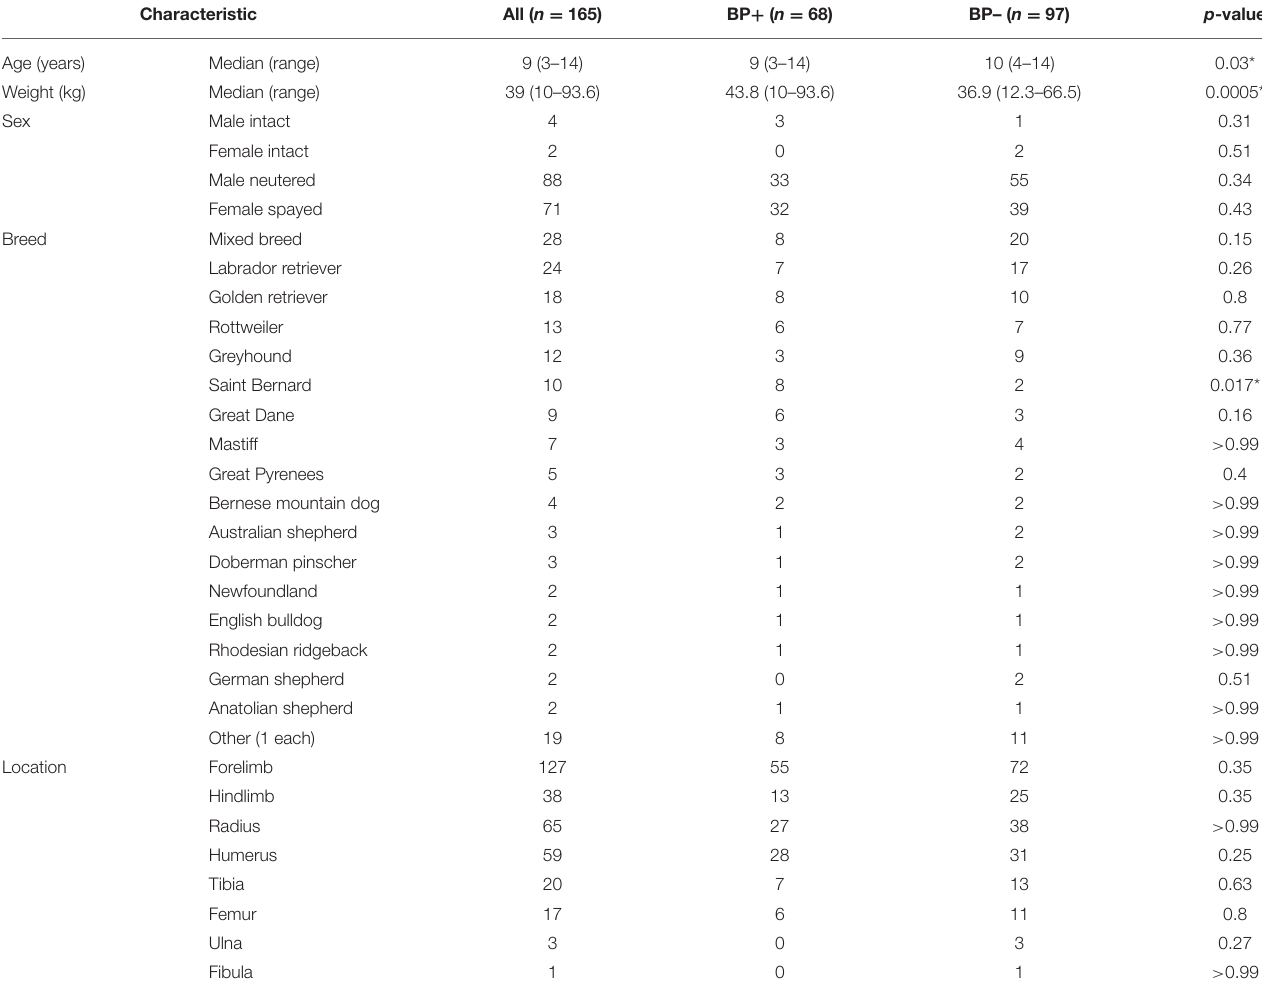
TABLE 1 | Signalment and tumor location information for all dogs, and by group.